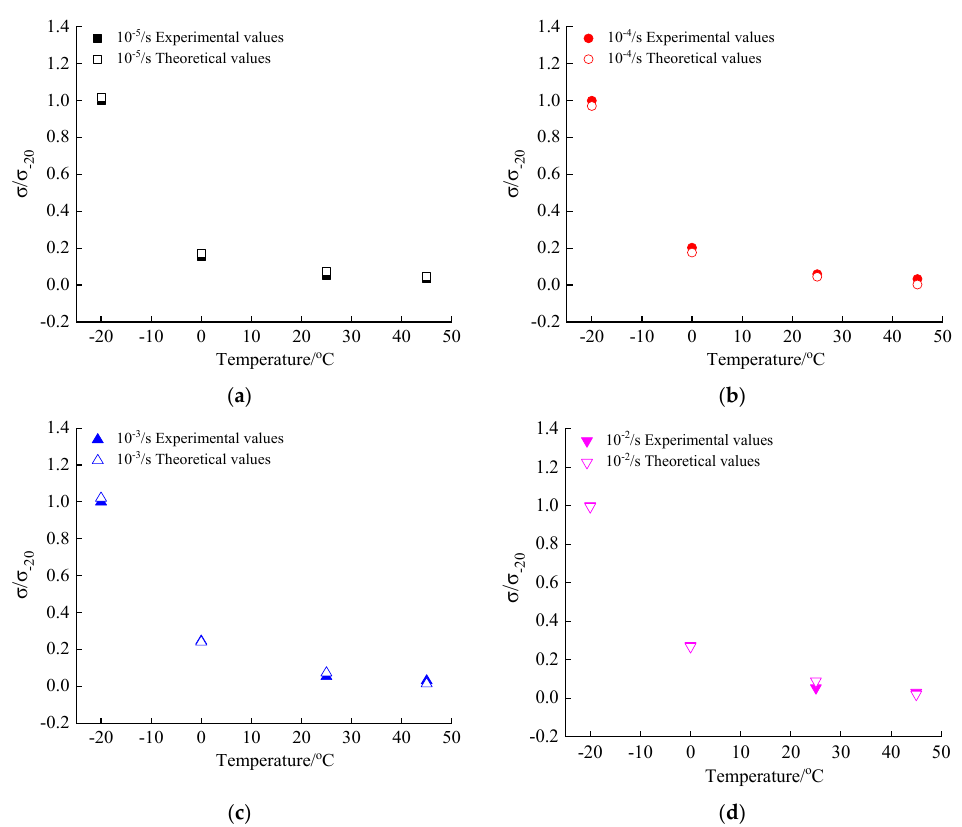
Figure 12. Comparison of theoretical and experimental values of peak compressive stress. ( a ) strain rate 10 -5 /s; ( b ) strain rate 10 -4 /s; ( c ) strain rate 10 -3 /s; ( d ) strain rate 10 -2 /s. 10 − 5 / s; ( b ) strain rate 10 − 4 / s; ( c ) strain rate 10 − 3 / s; ( d ) strain rate 10 − 2 / s.